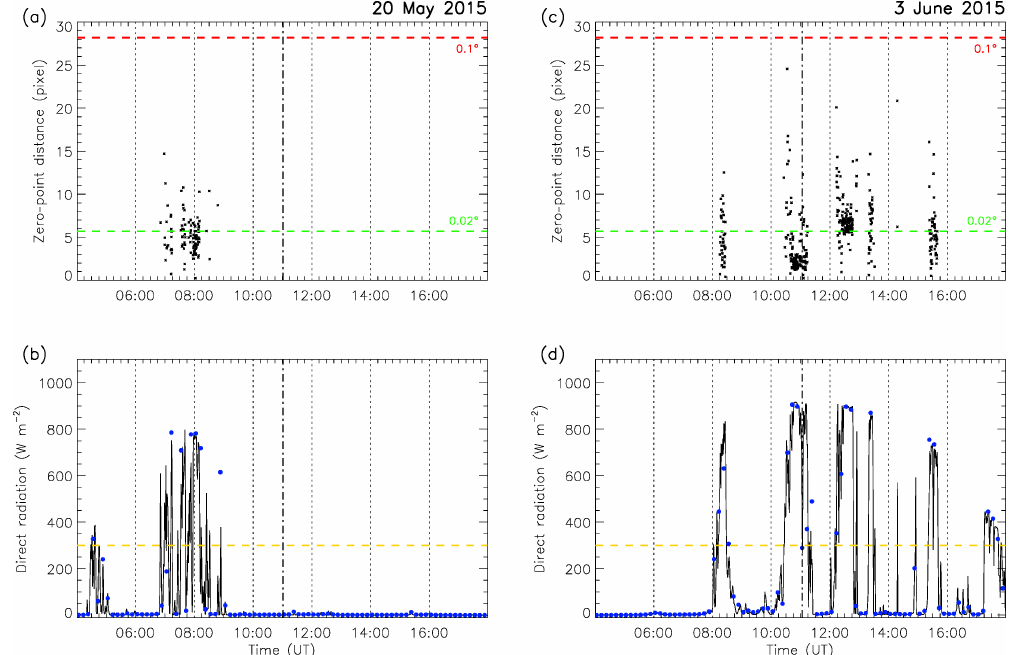
Figure 8. As Fig. 6, but for days with nearly perpetual overcast conditions (left, 20 May 2015; right, 3 June